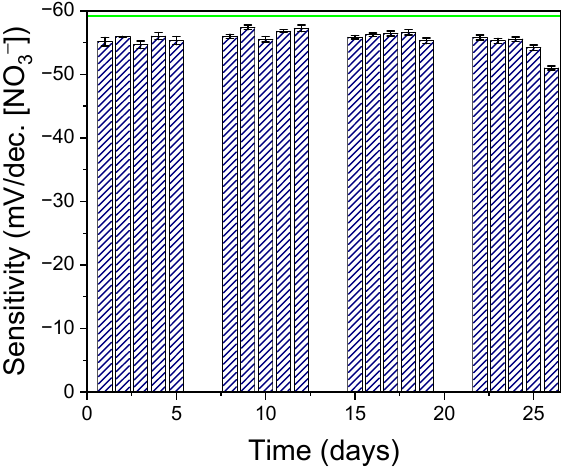
Figure 5. Reproducibility study. Characterization of the response of the sensor measured in tripli- cate during different days and weeks. The green line represents the Nernstian theoretical value ( − 59.2 mV/dec to NO 3 − at 25 °C).